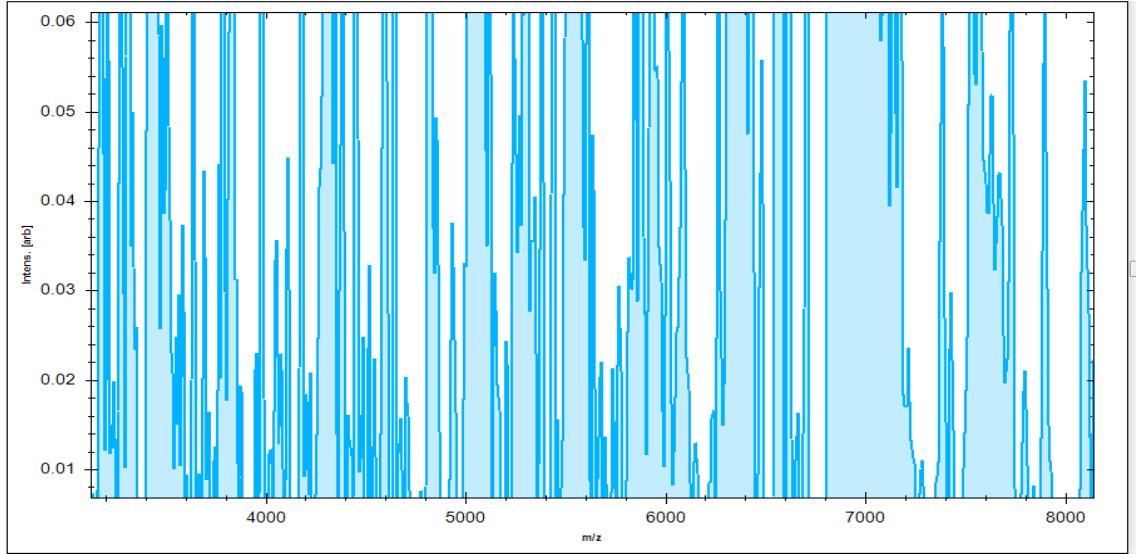
Figure 2. Higher peak intensity was concentrated between 3000 and 8000 Da.